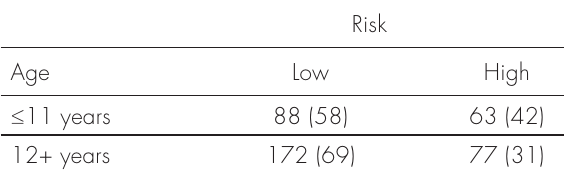
Table VI. Association between age and risk category.